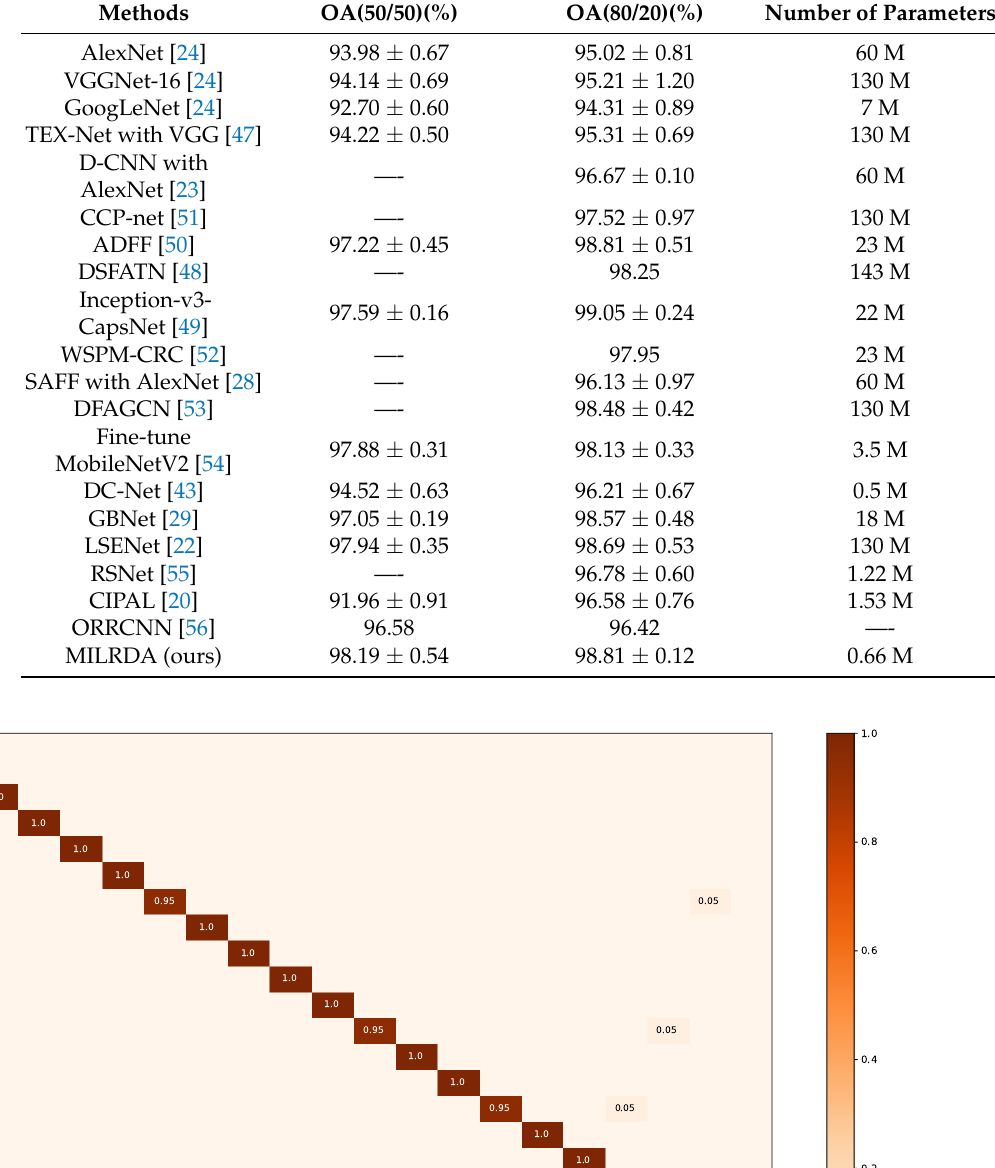
Table 2. Performance comparison on the UCM dataset(—-: not reported).